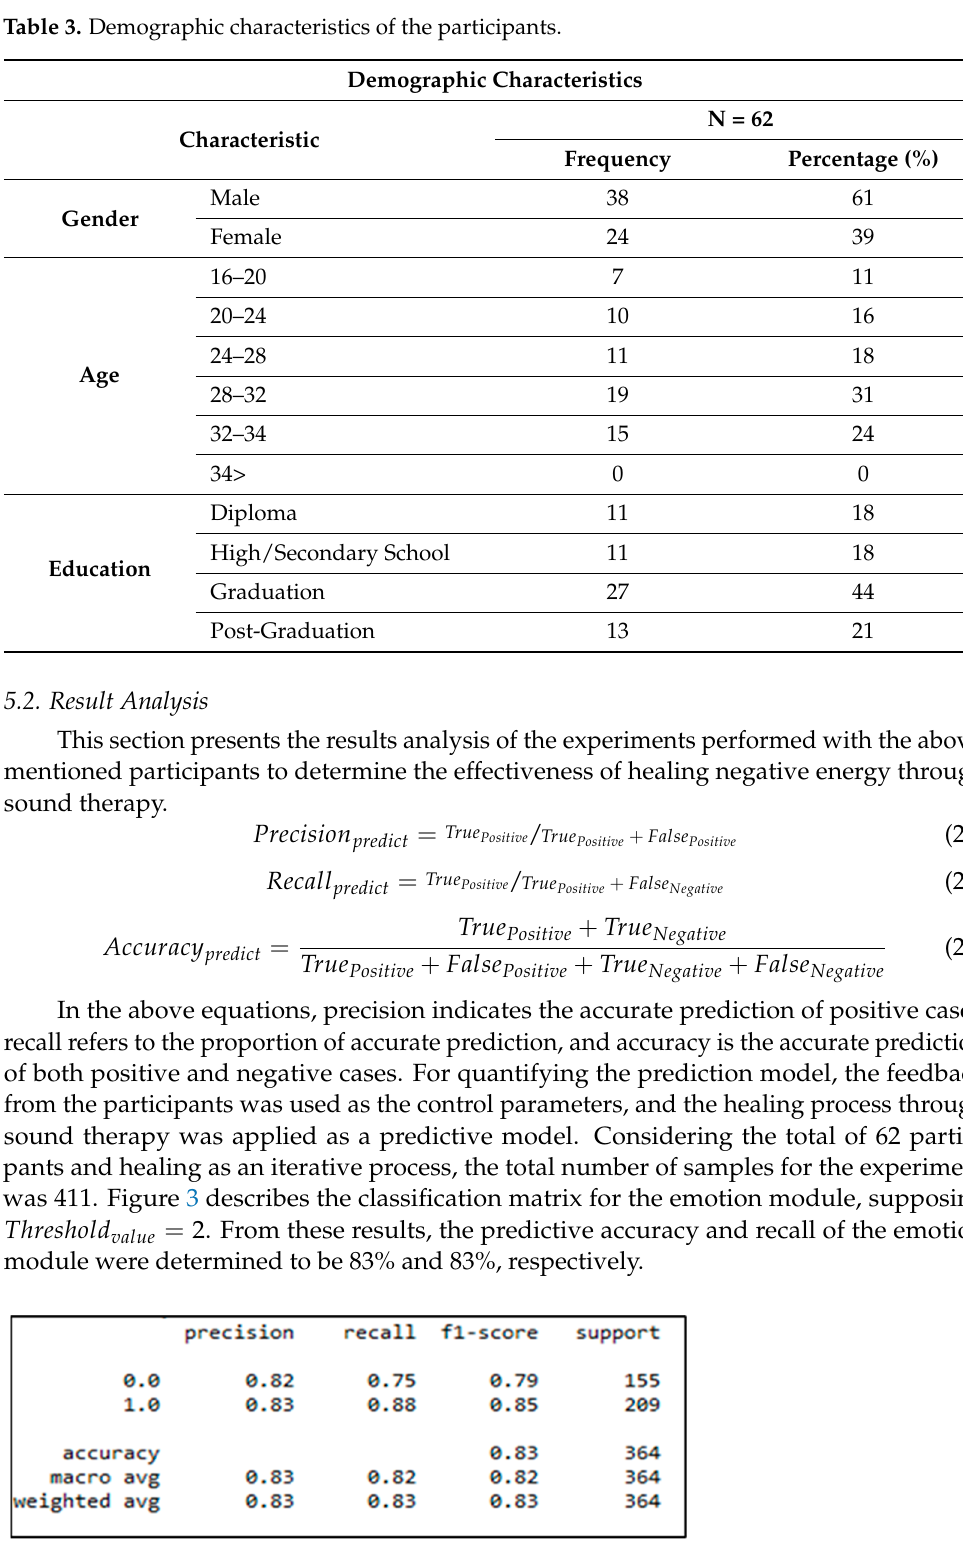
Figure 4. Training and validation accuracy (above) and loss (below) for the emotion module.